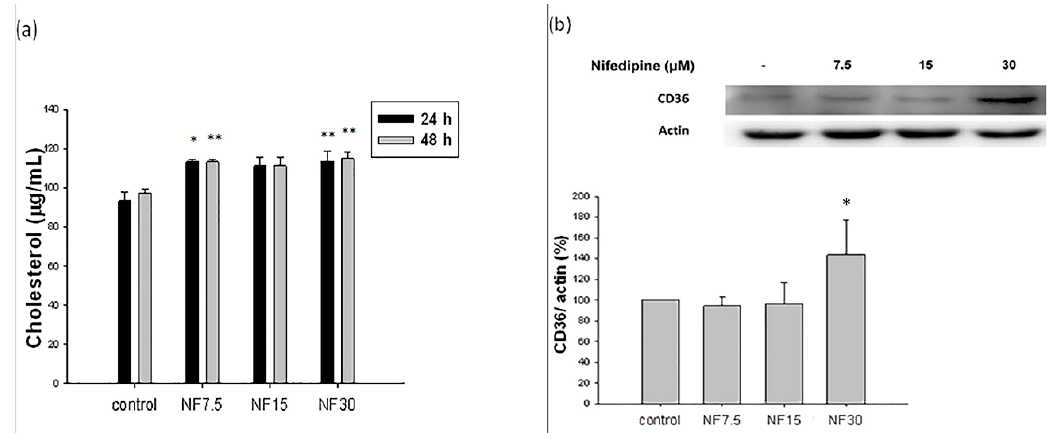
Figure 3. Nifedipine stimulated cholesterol biosynthesis and CD36 protein: ( a ) in a non-dose or